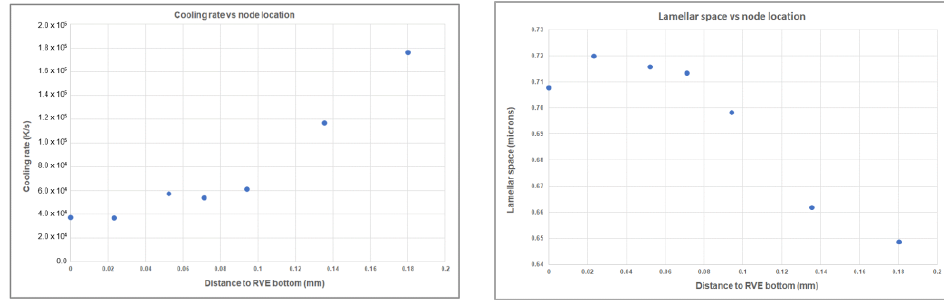
Figure 15. Cooling rate ( left ) and lamellar spacing ( right ) vs. nodes location.